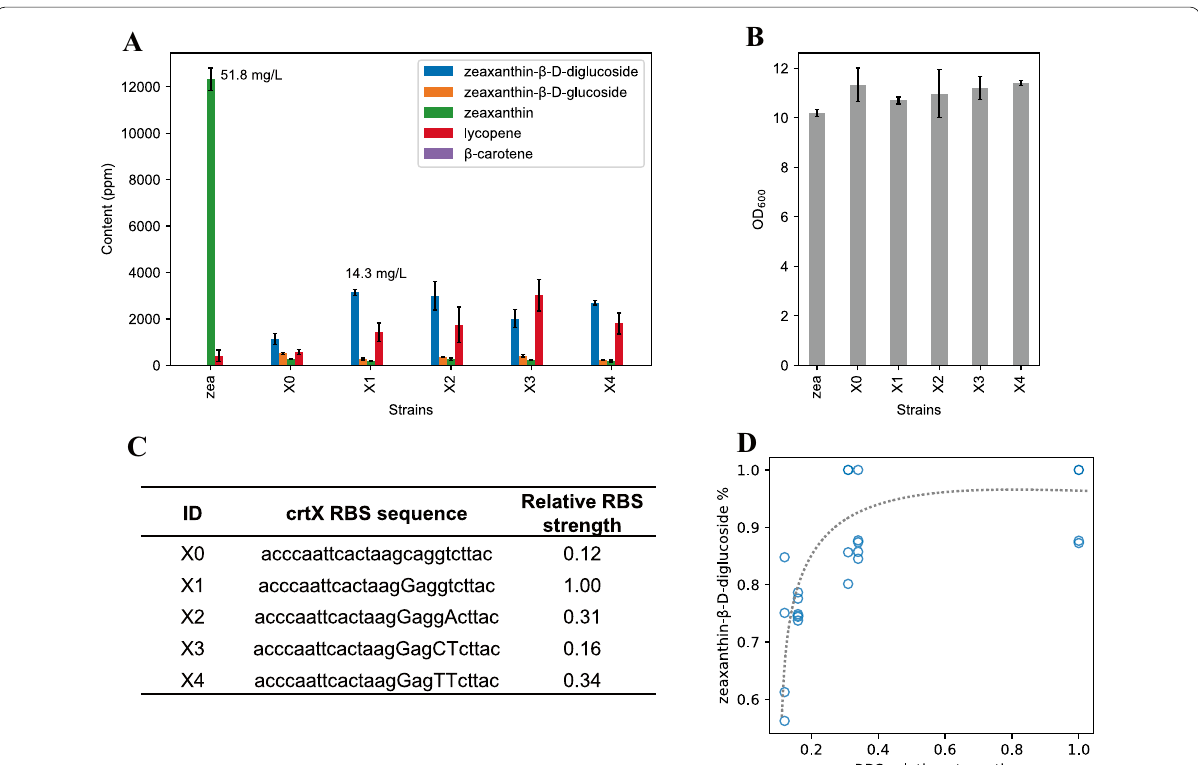
Fig. 3 Tuning the translation of zeaxanthin glucosyltransferase. A Carotenoid contents of zeaxanthin glucoside strains. ‘zea’ strain is the parental zeaxanthin strain without expressing crtX . B OD 600 of different strains. Error bars, mean relative strengths. D Correlation between the glycosylation efficiency of zeaxanthin and the RBS strength of crtX . The glycosylation efficiency is defined as the percentage of zeaxanthin diglucoside yield to the total yield of zeaxanthin and its two